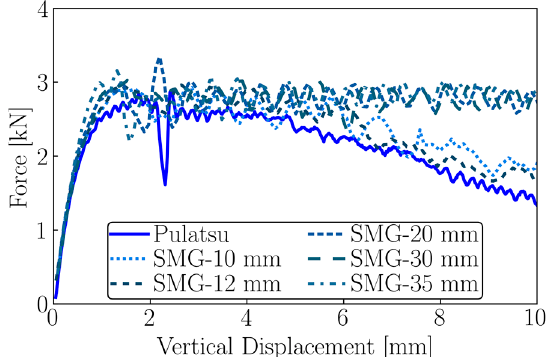
Figure 8. Mesh sensitivity for 10 mm/s loading velocity (the sudden drop of the force post-peak indicates the ‘stick-slip’